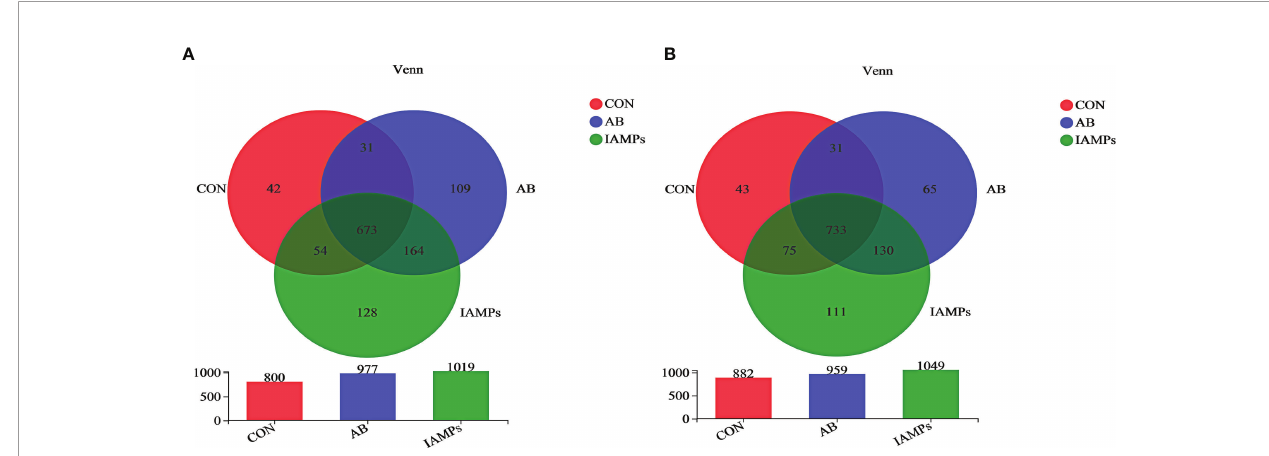
FIGURE 2 | Effect of IAMPs on OTU for digesta samples of weaning piglets. (A) Cecum; (B) colon. The individual pig was regarded as the experimental unit (n = 5). CON, corn – soybean meal-based diet; AB, CON + 25 mg/kg fl avomycin + 50 mg/kg quinocetone; IAMPs, CON + 1,000 mg/kg